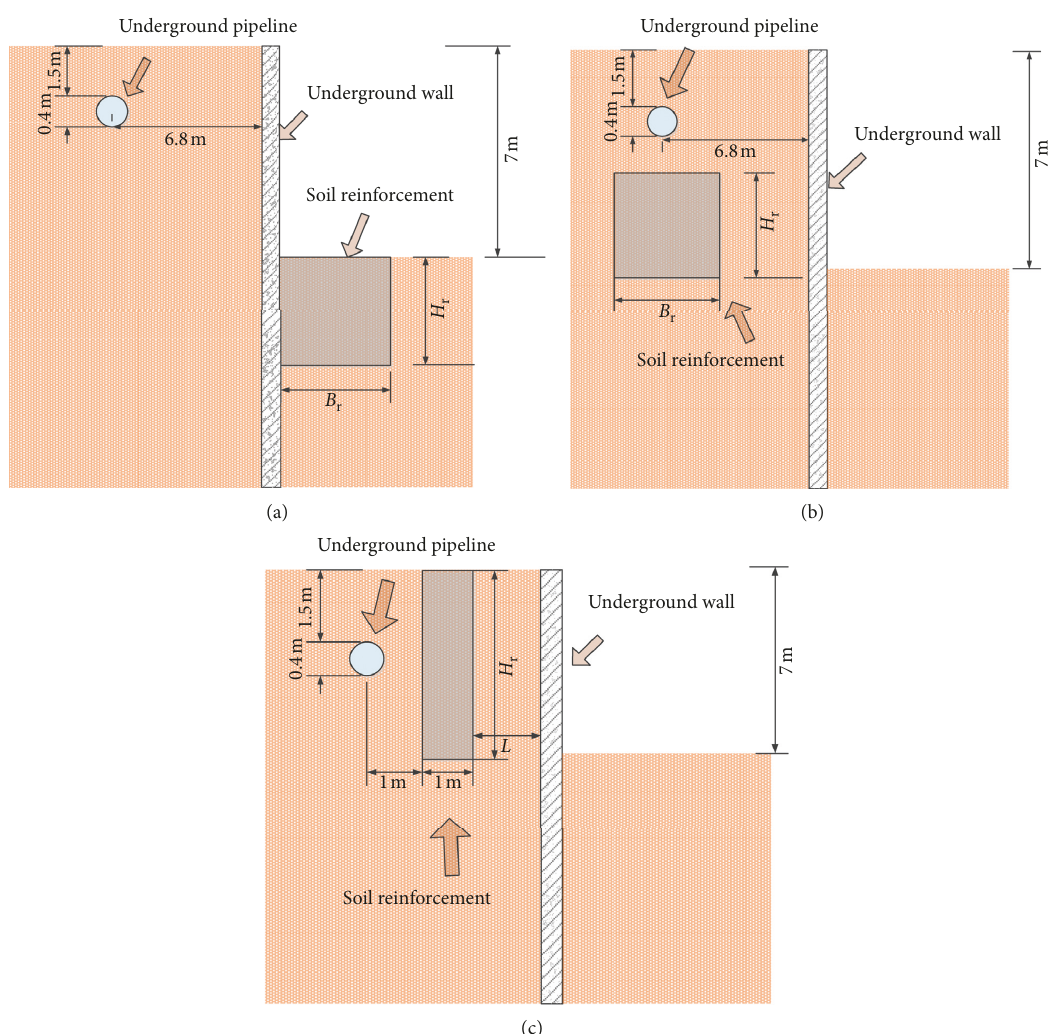
Figure 11: An illustration of the different reinforcement measure. (a) The RS at passive zone in the pit. (b) The RS underneath pipeline. (c) The RS between pipeline and